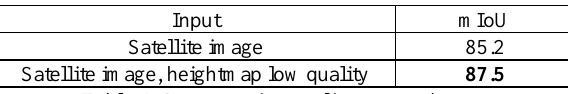
Table 4. Segmentation quality on test dataset